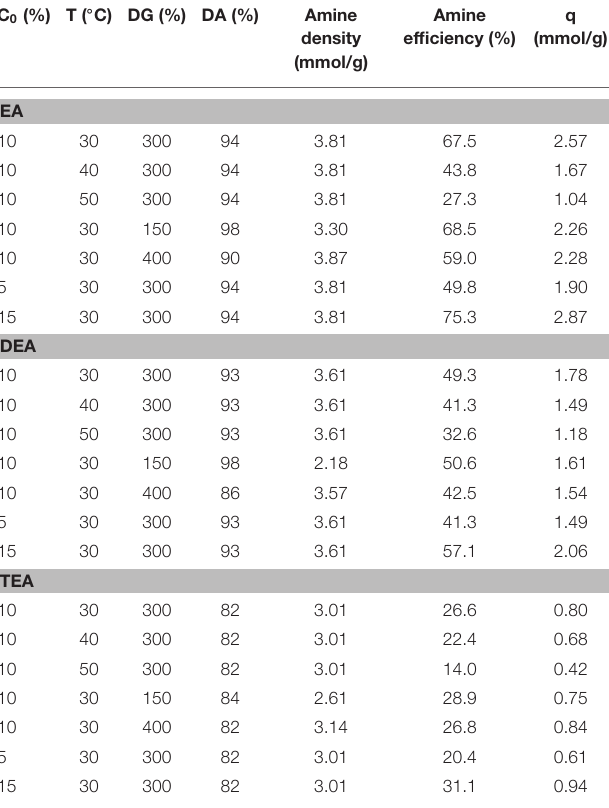
TABLE 1 | Comparison between the adsorption capacities of aminated